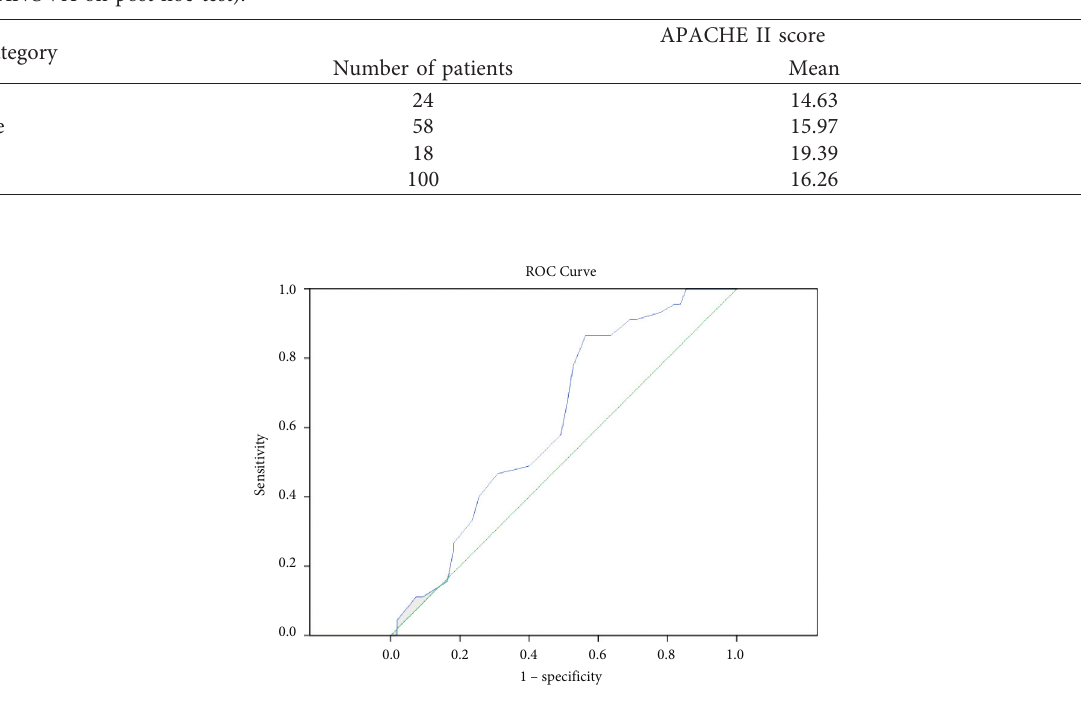
Table 4: Depiction of the mean and SD of the APACHE II scores in the three categories of ARDS ( p < 0 . 05 between mild and severe ARDS, one-way ANOVA on post hoc test).